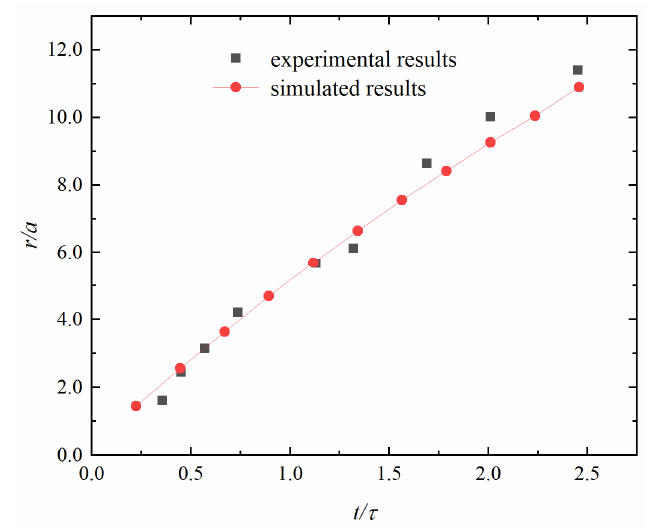
Figure 5. Comparison between simulated data and experimental data.